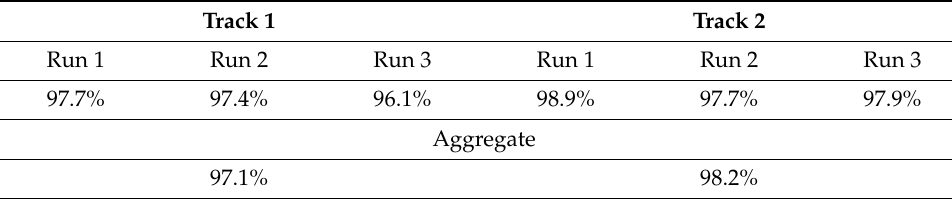
Table 4. The percentage of successful